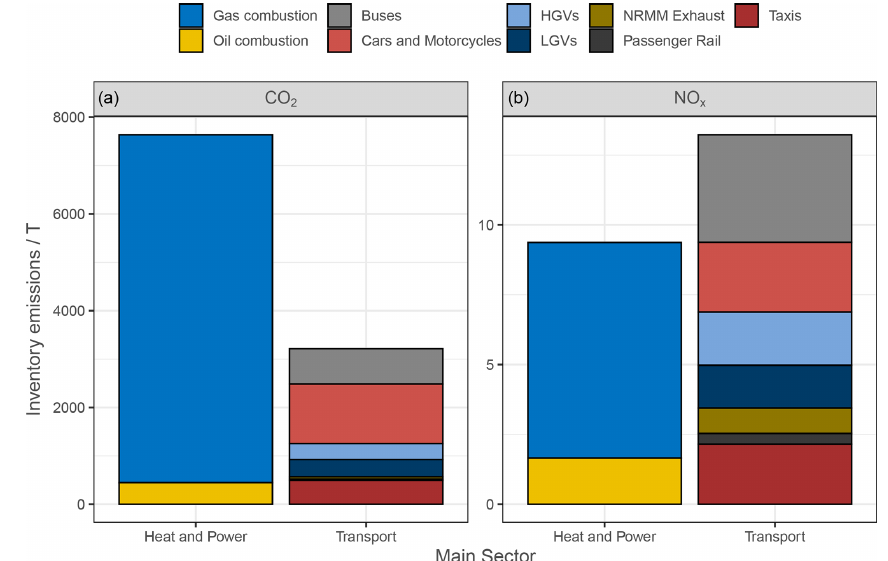
Figure 3. Inventory-estimated breakdown of emissions for CO 2 (a) and NO x (b) in tonnes for March through August of 2017, as determined from the inventory emissions extraction for our 1-hourly measurement footprints. LGV = light-goods vehicles; HGV = heavy-goods vehicles; NRMM = non-road mobile